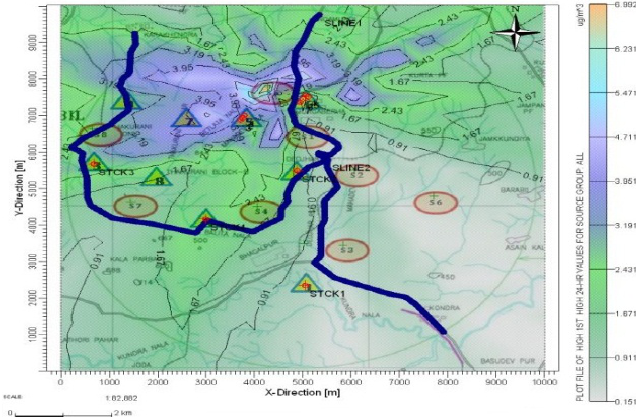
Fig. 3: Isopleths of overall impact – NO 2 (Max. Conc. = 15.98µg/m 3 ) Fig. 2: Isopleths of overall impact – SO